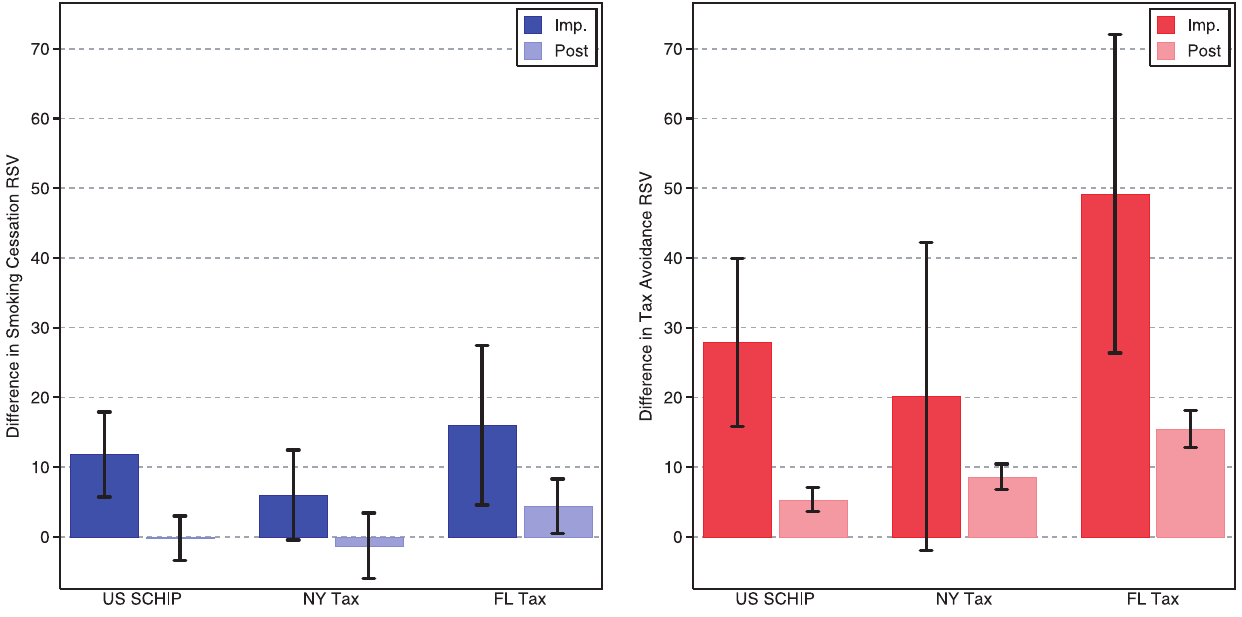
Figure 2. Impact of cigarette taxes on cessation and avoidance during implementation (dark) and post (light) periods. Note: Bars show the mean effect of each tax, and lines indicate the 95% confidence interval, during the implementation period (Imp.) and post (Post) period.